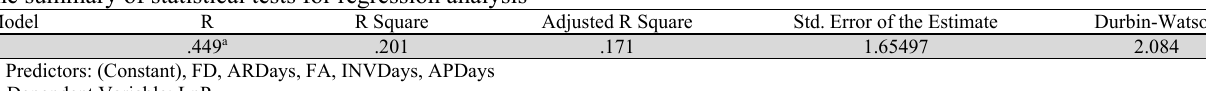
The summary of statistical tests for regression analysis